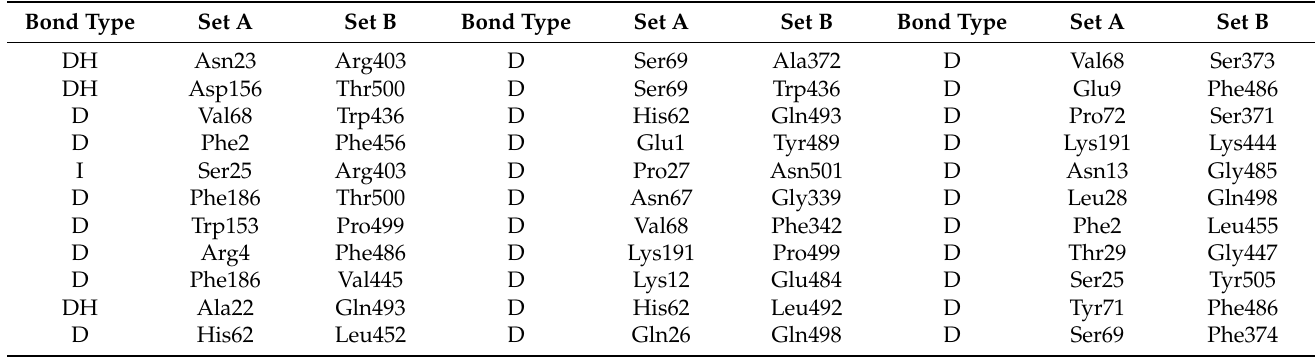
Table 3. All residues involved in the bond between the α 7nAChr (PDB:7KOX) and the original SARS-CoV-2 spike protein (PDB:6VSB), with bond type interactions: distance (D), hydrogen bond (H), and ionic (I). Set A refers to α 7nAChr, set B refers to spike protein. The explanation of